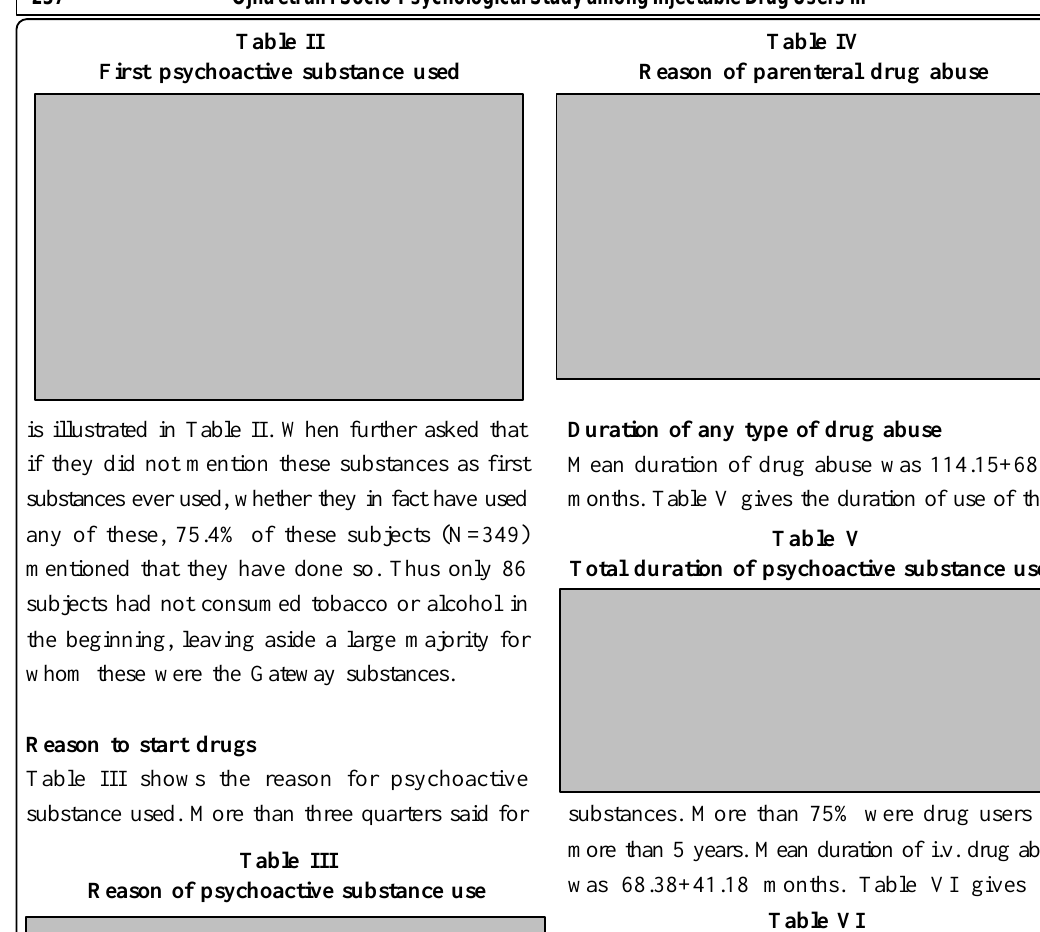
Duration of i.v. drug